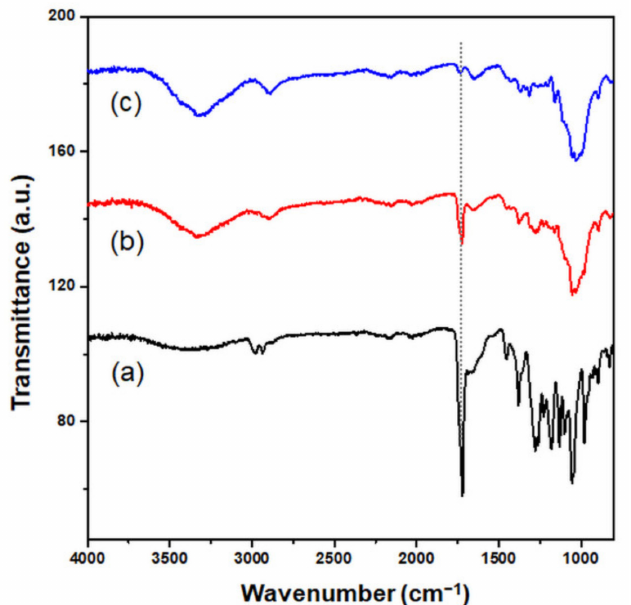
Figure 5. FTIR spectra of PHB produced from C. necator fermentation ( a ) without CNCs, ( b ) with 0.04 g/L CNCs, and ( c ) with 0.04 g/L CNCs added after